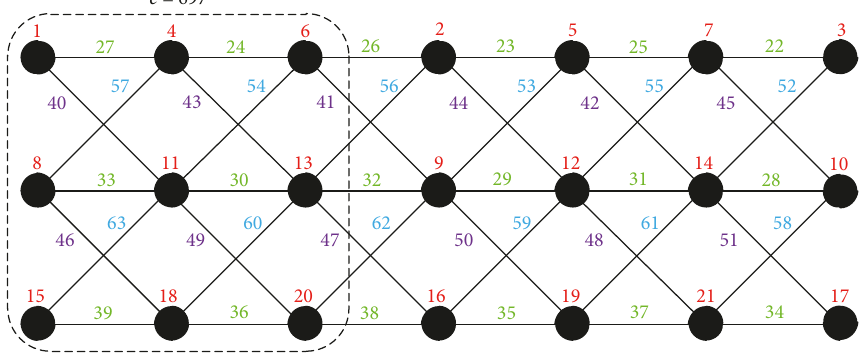
Figure 1: 𝐷 3 (𝑃 3 ) -supermagic labeling of 𝐷 3 (𝑃 7 ) with magic constant 𝑐 =